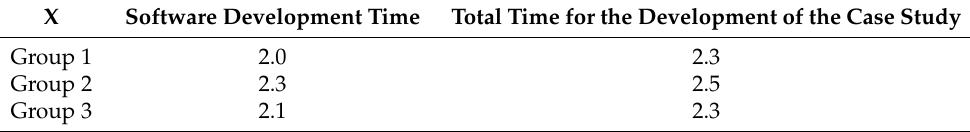
Table 2. Time records for the execution of the case study with